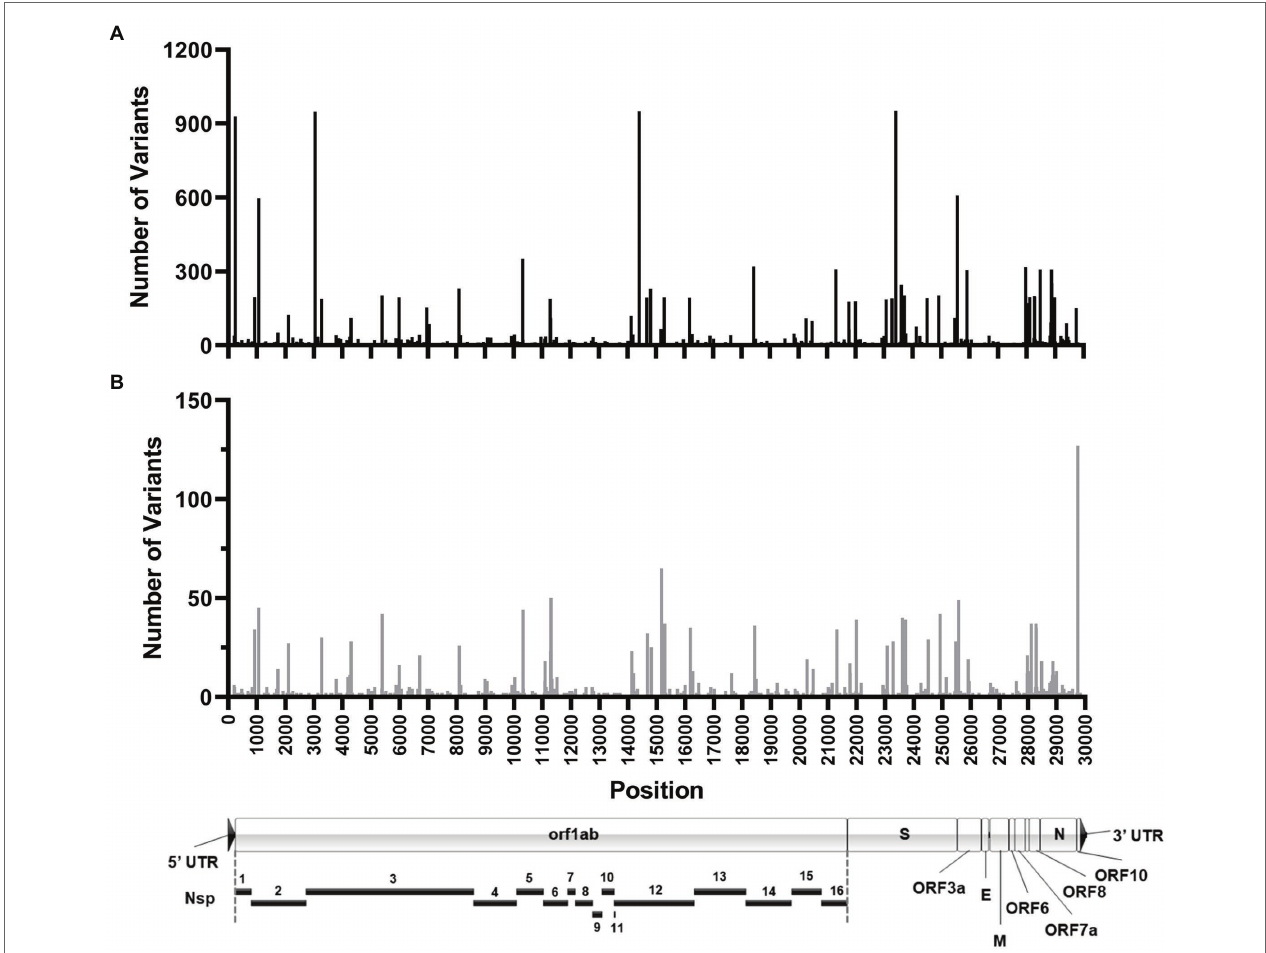
FIGURE 9 | Location of SARS-CoV-2 variation identified in samples. Histograms shows the number of high-quality major (A) and minor (B) variants identified at each genomic position in all the patient samples sequenced. Position location is relative to the Wuhan-Hu-1 reference genome. (A) To-scale map of the genome is shown below with known proteins labeled. Nsp, nonstructural protein.